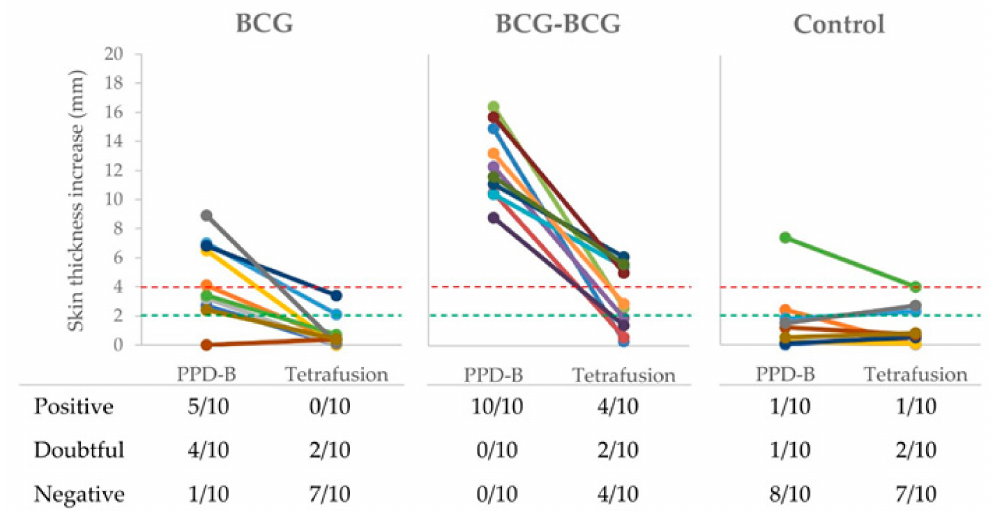
Figure 4. Skin tests. Individual skinfold thickness using M. bovis tuberculin (PPD-B) and a Tetrafusion protein (ESAT-6 / CFP-10 / RV3615c / Rv3020). BCG (single BCG-vaccinated group), skin tested one year after vaccination; BCG-BCG (revaccinated group after one year of first vaccination), skin tested three weeks after revaccination; Control: unvaccinated group. Red dashed line: threshold for positive results in the skin test. Green dashed line: threshold for doubtful results in the skin test. In the table, qualitative results of skin tests are presented per